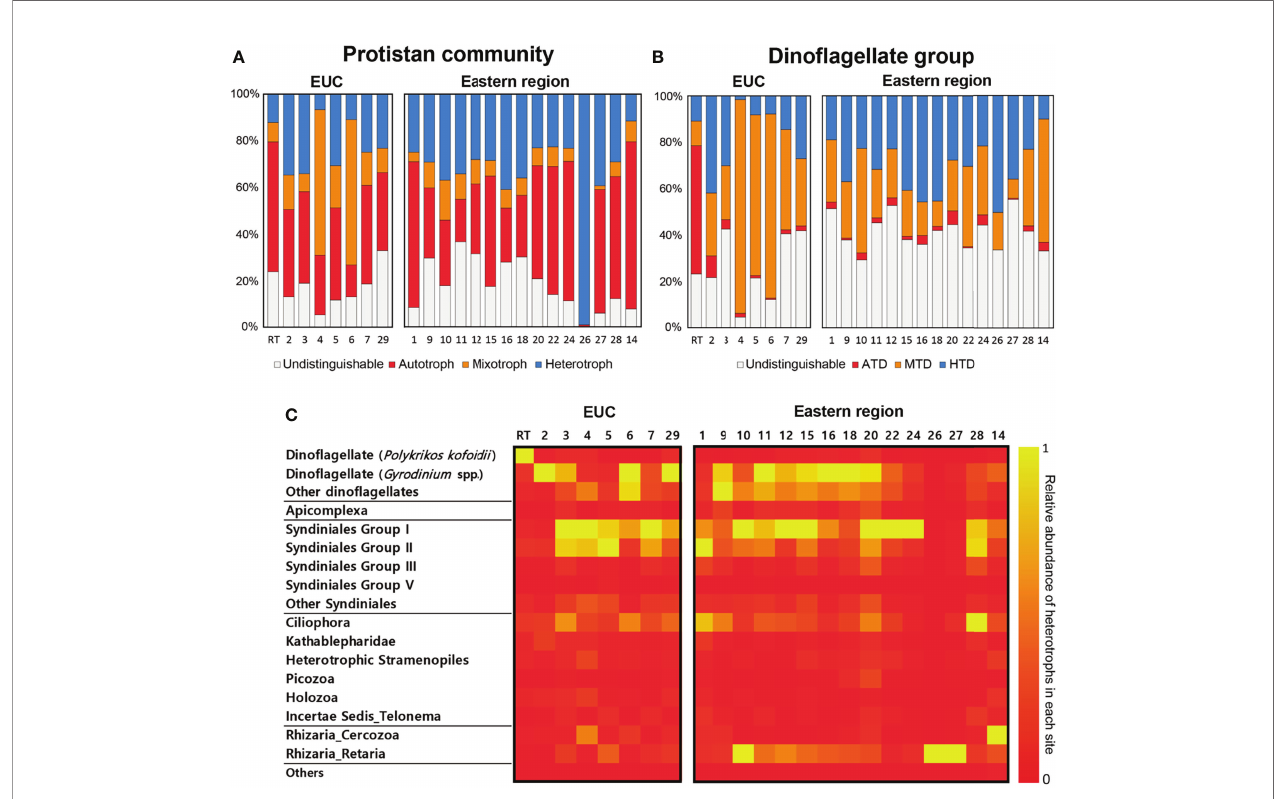
FIGURE 6 | Functional classi fi cations of the protistan community and the dino fl agellates in relation to their trophic modes based on read abundances of 18S rRNA gene amplicon sequencing. (A) Protistan community and (B) Dino fl agellate groups. ATD, autotrophic dino fl agellate; MTD, mixotrophic dino fl agellate; HTD, heterotrophic dino fl agellate. (C) Relative abundance of heterotrophic protists in each sample. Sites are separated by region where Equatorial undercurrent upwelling (EUC) sites are on the left and Eastern region sites are on the right. The trophic modes of dino fl agellates were annotated at the species/genus levels and for the other protists generally at order/class levels according to the cited references. If the dino fl agellate genus is known to have at least one mixotrophic species, the genus was classi fi ed as a potential mixotroph. See Supplementary Table 2 for detailed ASV